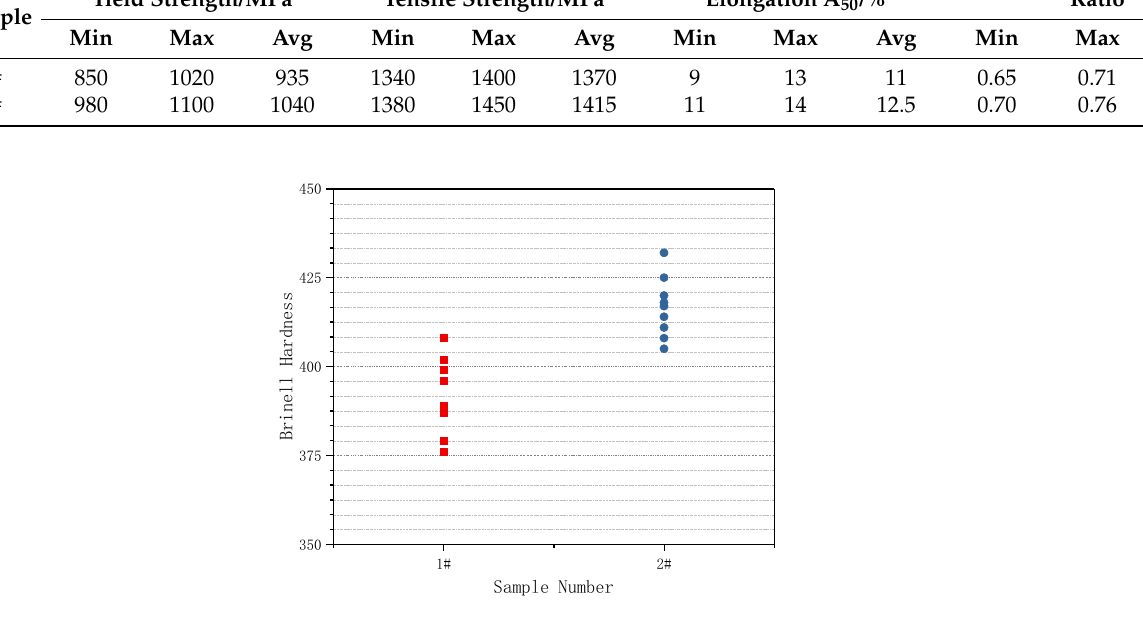
Figure 14. Brinell hardness of tested steels on surface.